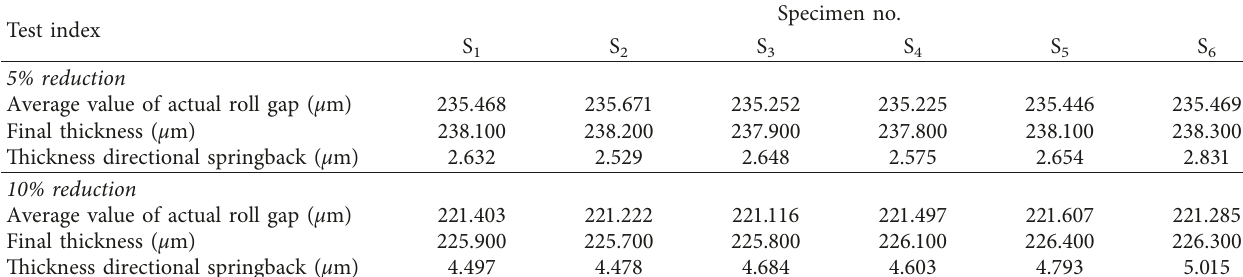
Figure 5: Overviews and magnified profiles in thickness transition areas of the microflexible rolled 304 stainless steel specimens S Table 3: Experimental results for the microflexible rolled 304 stainless steel specimens.